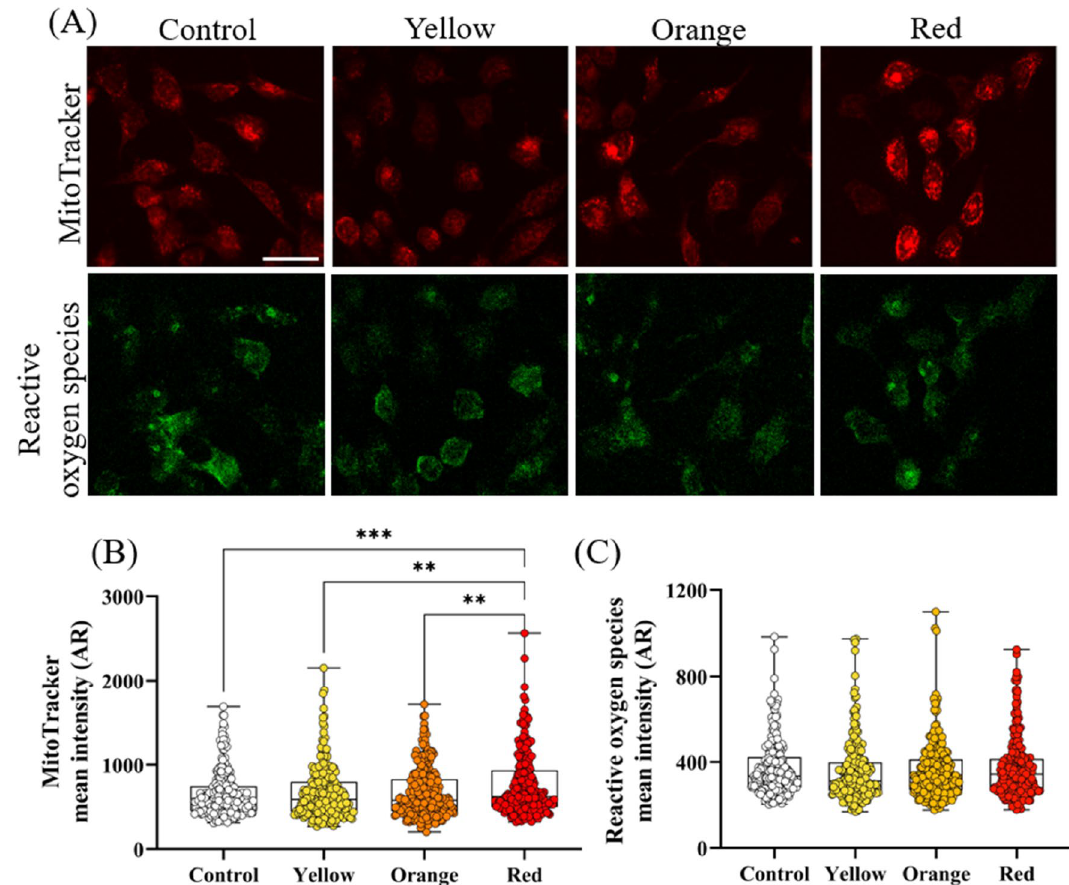
Figure 5. Effect of different wavelengths of visible light radiation on mitochondria membrane potential and oxidative stress in HaCaT cells. ( A ) Immunofluorescent image of MitoTracker and reactive oxidative stress stains ( B ) Quantification of fluorescence intensity of MitoTracker .( C ) Quantification of fluorescence intensity of oxidative stress. In ( B , C ) each dot represents a single cell and at least 240 cells across four